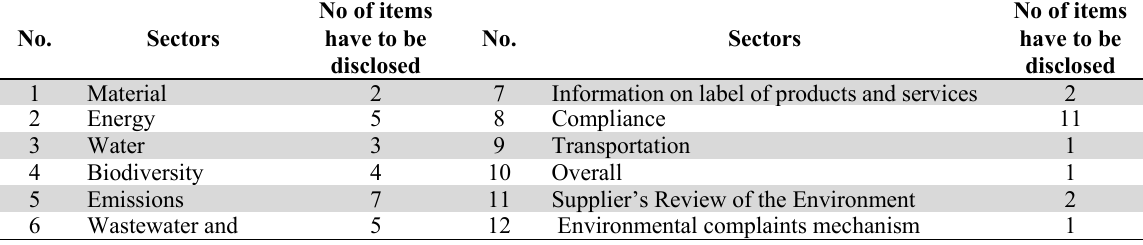
Items for Mandatory Environmental Information